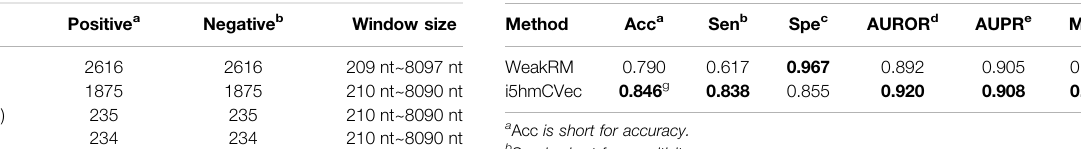
TABLE 1 | Dataset distributions of i5hmcVec and WeakRM. TABLE2|